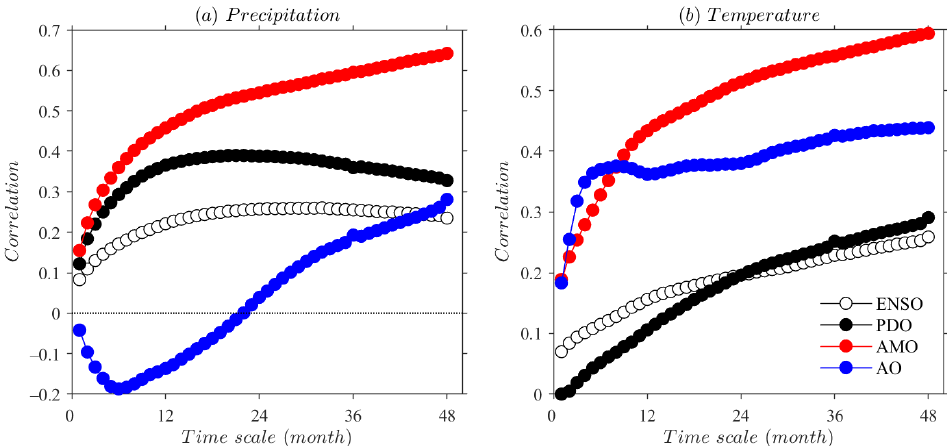
Figure 12. Pearson correlation coefficients between ( a ) precipitation and ( b ) temperature and telecon- nection indices (NINO3.4, PDO, AMO, and AO) over Xinjiang on 1- to 48-month time scales during